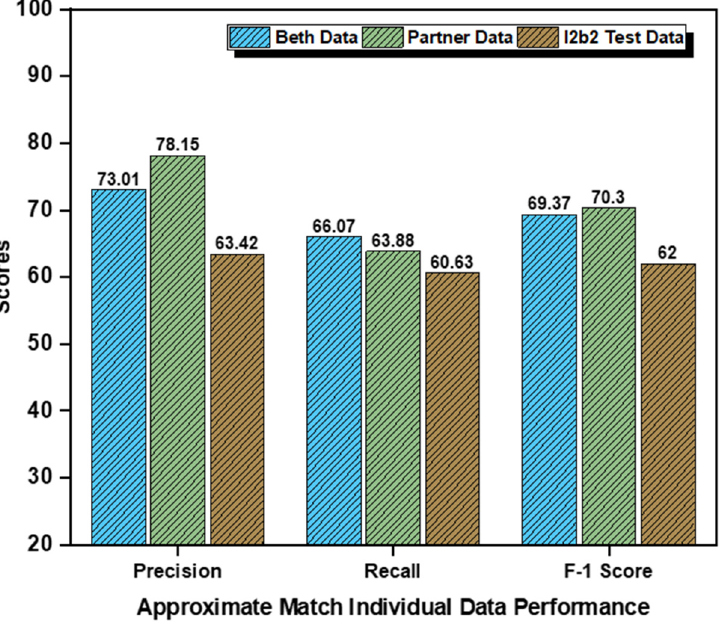
Figure A2. Individual dataset performances, employing approximate term matching to UMLS.